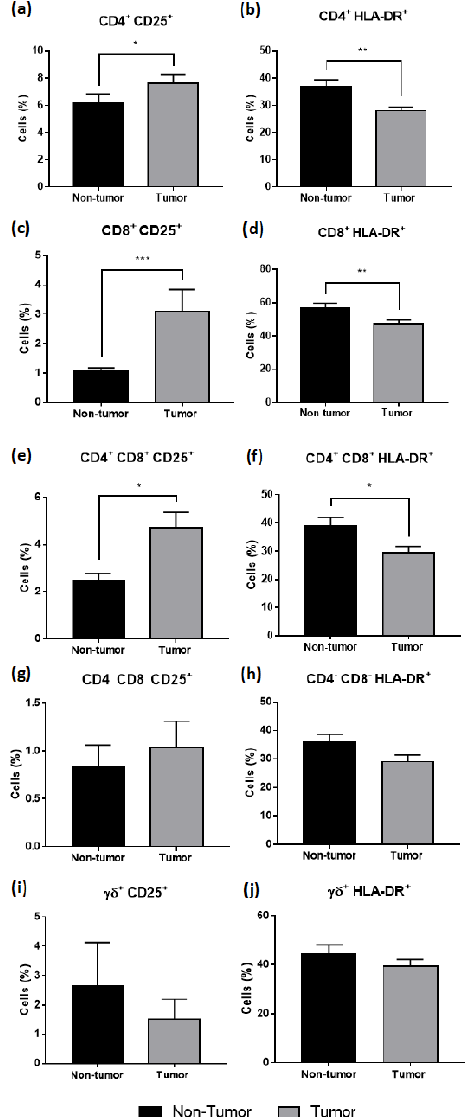
Figure 5. Analysis of the activation profile of T cells in non-tumor and tumor samples of CRC liver metastasis. Assessment of the expression of CD25 + and HLA-DR + in CD4 + ( a , b ), CD8 + ( c , d ), CD4 + CD8 + ( e , f ), CD4 — CD8 — ( g , h ), and γδ + ( i , j ). All results are shown as mean ± SEM. * p < 0.05, ** p < 0.01 and *** p < 0.001 were significantly different when compared to non-tumor samples using Mann–Whitney